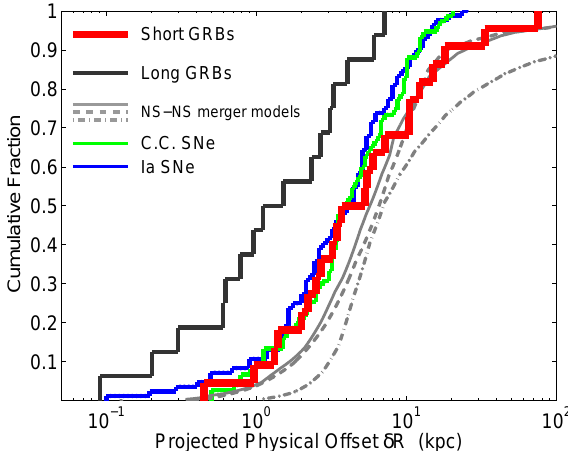
Figure 2. Cumulative distribution of projected physical off-sets for 22 short GRBs with sub-arcsecond positions (red; from [11]). Also shown are the cumulative distributions for long GRBs (black), core-collapse SNe (green), Type Ia SNe (blue); and predicted off-sets for NS–NS binaries (grey). Source: Figure 5 in [14]